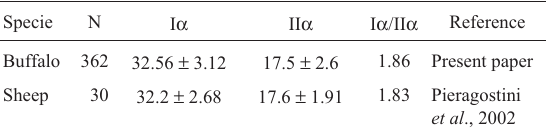
Table2 -Percentgeneefficiencies(mean ± sd),fromthe5’tothe3’endas calculated by densitometric data in buffalo and sheep.